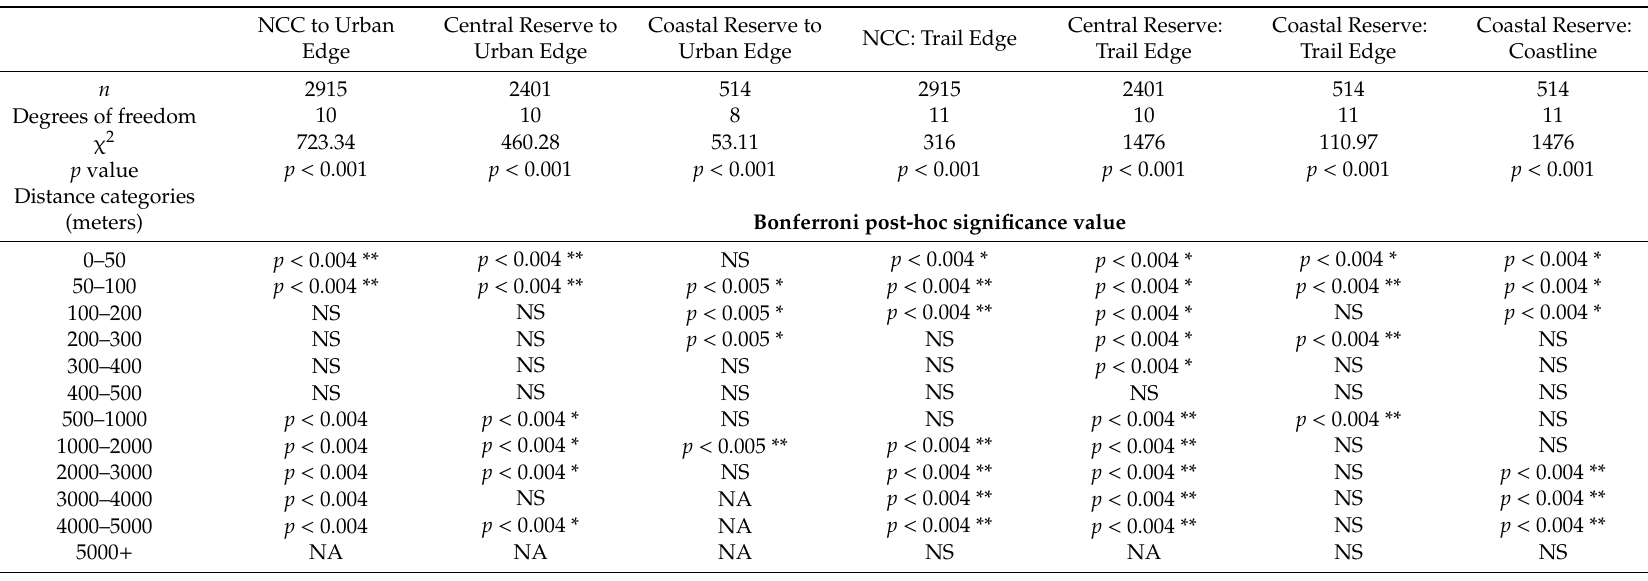
Table A6. Results of multiple chi-square analyses for rare plants per area meters from an edge. Bonferroni post hoc significance values are listed for each category. p values with one asterisk (*) indicate that the number of rare species observations were significantly higher than expected (assuming random distribution across the reserve) and p values with two asterisks (**) that the number of rare plant occurrences were significantly lower than expected. NS indicates insignificant results; NA means there was not data that fell into that category, so the test was not